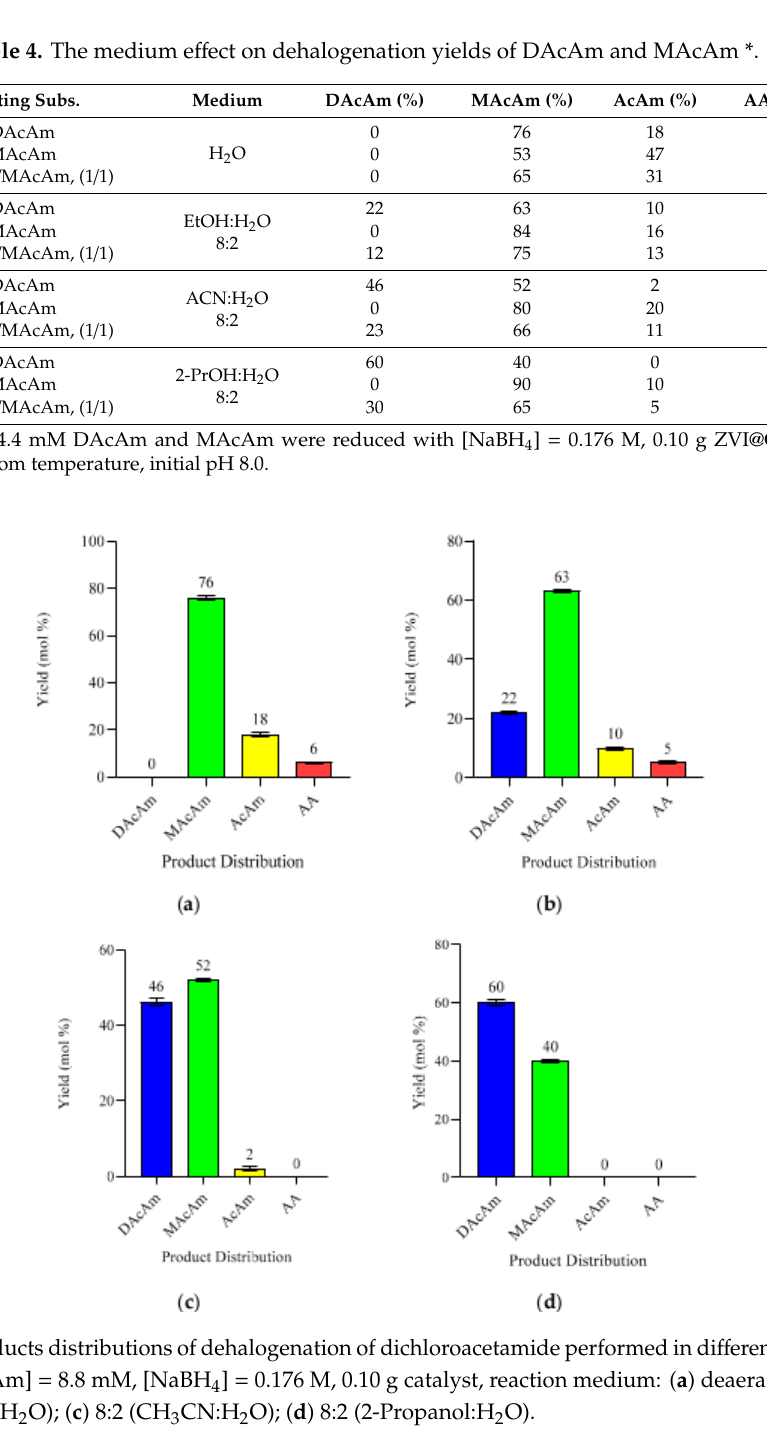
( b ) 8:2 (EtOH:H 2 O); ( c ) 8:2 (CH 3 CN:H 2 O); ( d ) 8:2 (2-Propanol:H 2